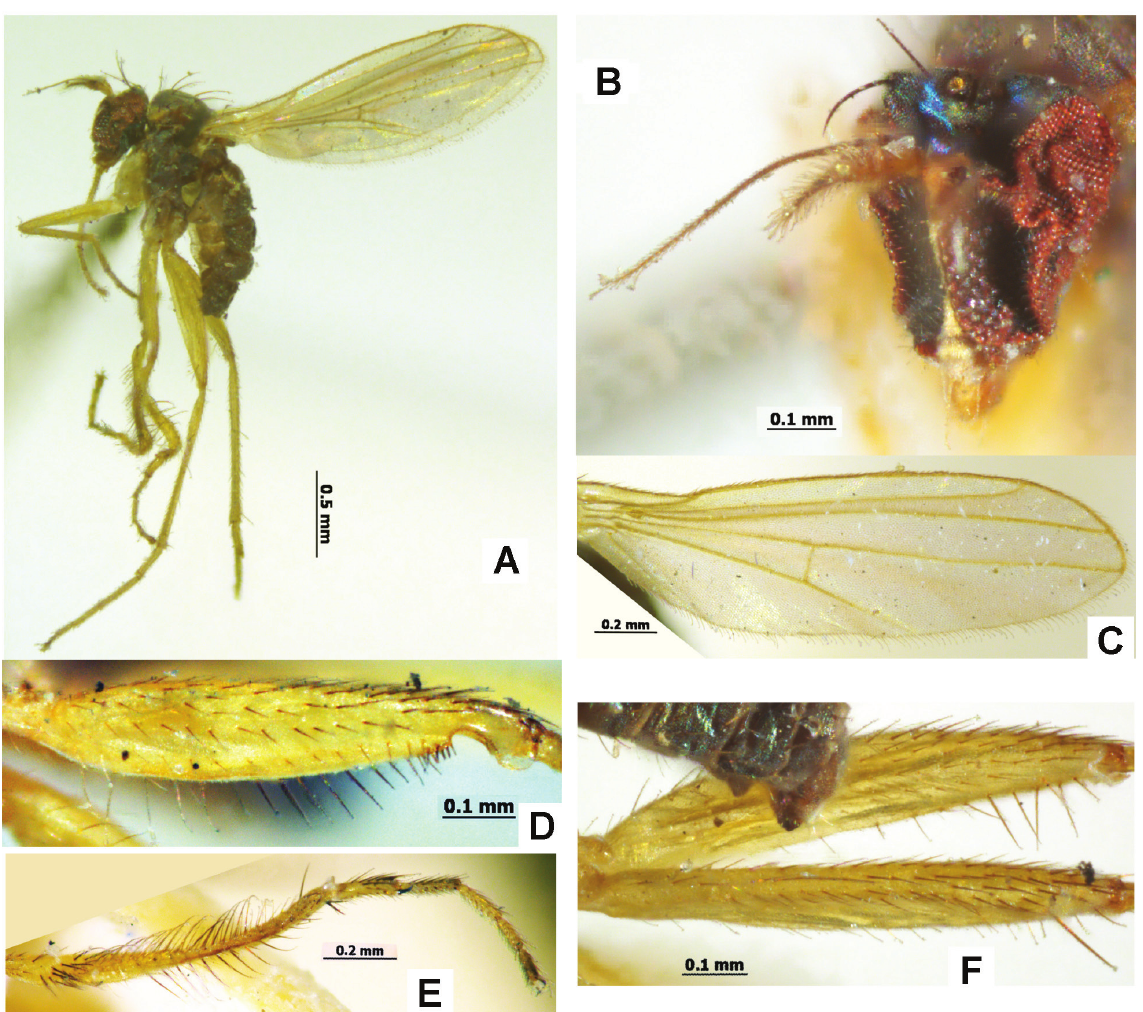
Fig. 1. Campsicnemus meridionalis sp. nov., ♂ holotype. A . habitus. B . head. C . wing. D . mid femur. E . mid tibia and tarsus. F .